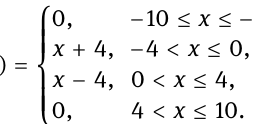
Figure 1. The relative errors of M1 and M2 for various α and δ 1 are presented in Table 1. It can be seen that when alpha is close to 1, the results of the two methods are close. With the increase of α , method 1 performs better than method 2, and the numerical results are more stable and the relative errors are smaller. Figures 2 and 3 exhibit the variation of E r with the changes of α and δ 1 , respectively. It can be seen that the method is stable for various α and δ 1 .